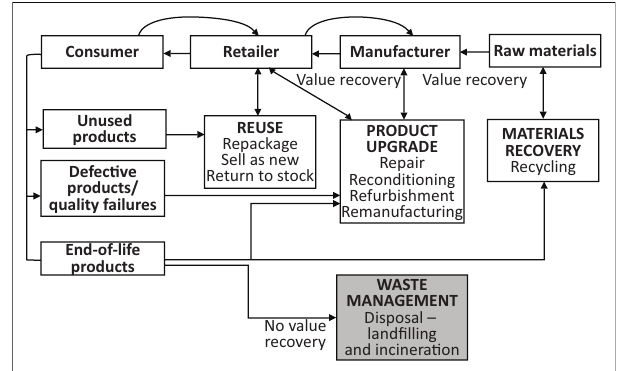
FIGURE 1: Disposition process in reverse